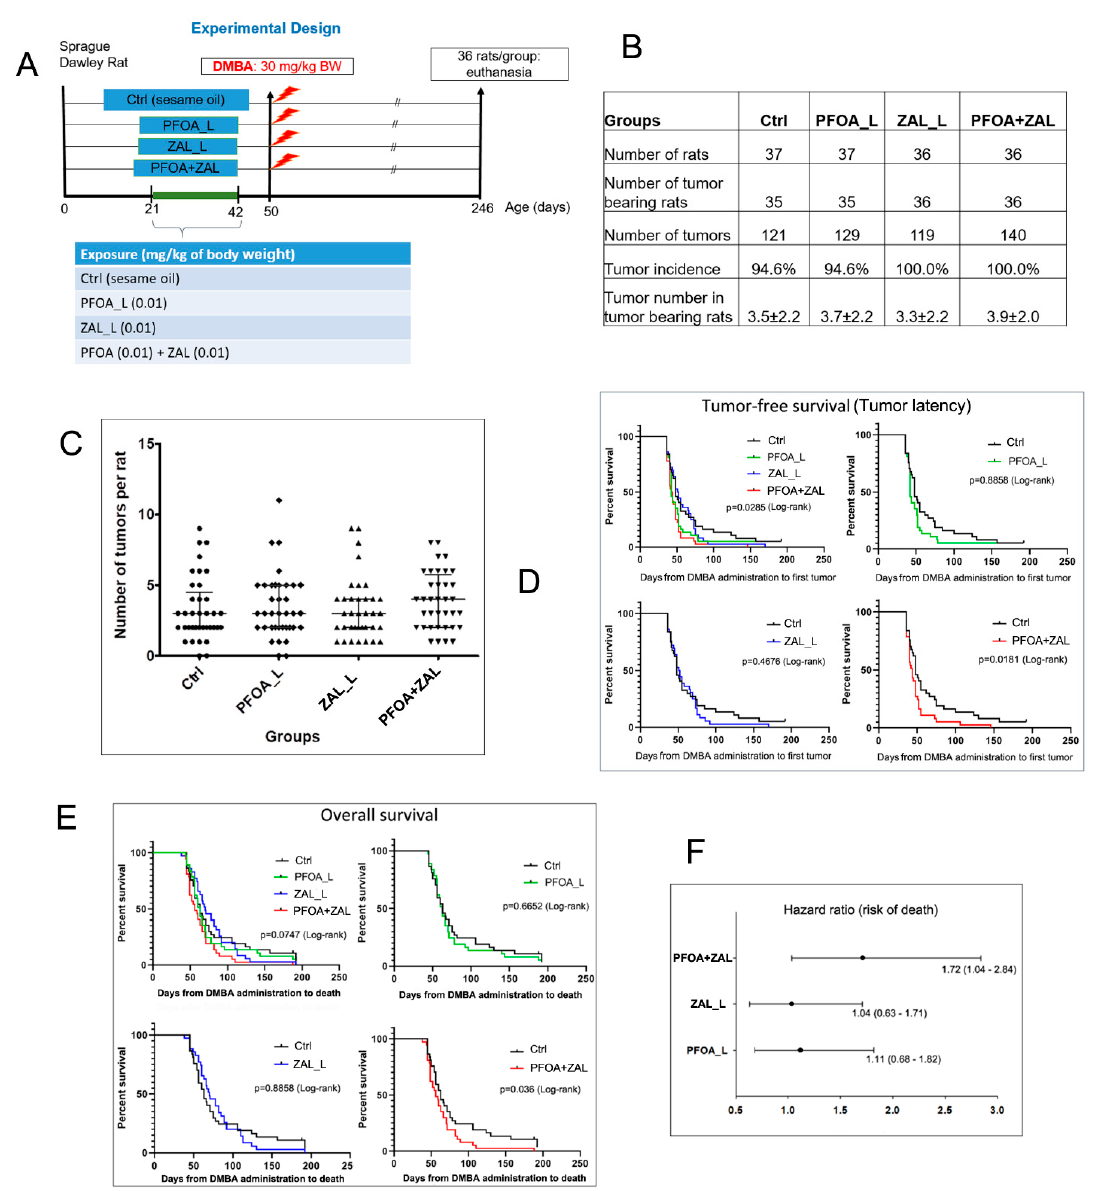
Figure 6. Effects of exposure to PFOA_L, ZAL_L, and PFOA + ZAL on mammary tumorigenesis: ( A ) Experimental design for the mammary tumorigenesis study. Female Sprague Dawley rats were treated with low doses of PFOA, ZAL, or their combination from ages of 21 to 42 days, and were given one dose of DMBA at 30 mg/kg body weight at the age of 50 days. ( B ) Table shows tumor incidence and the numbers of tumors in tumor-bearing rats. ( C ) Dot plots show the number of mammary tumors developed in each rat; each dot represents one rat. One-way ANOVA, p = 0.674. The three lines in the dot plots indicate the lower quartile, median, and upper quartile. ( D ) Kaplan-Meier tumor-free survival calculated by the time period from DMBA administration to the appearance of the first tumor, indicating tumor latency. ( E ) Kaplan-Meier overall survival calculated by the time period from DMBA administration to the day of euthanasia. ( F ) Hazard ratio analysis of risk of death using Prism 8.0.